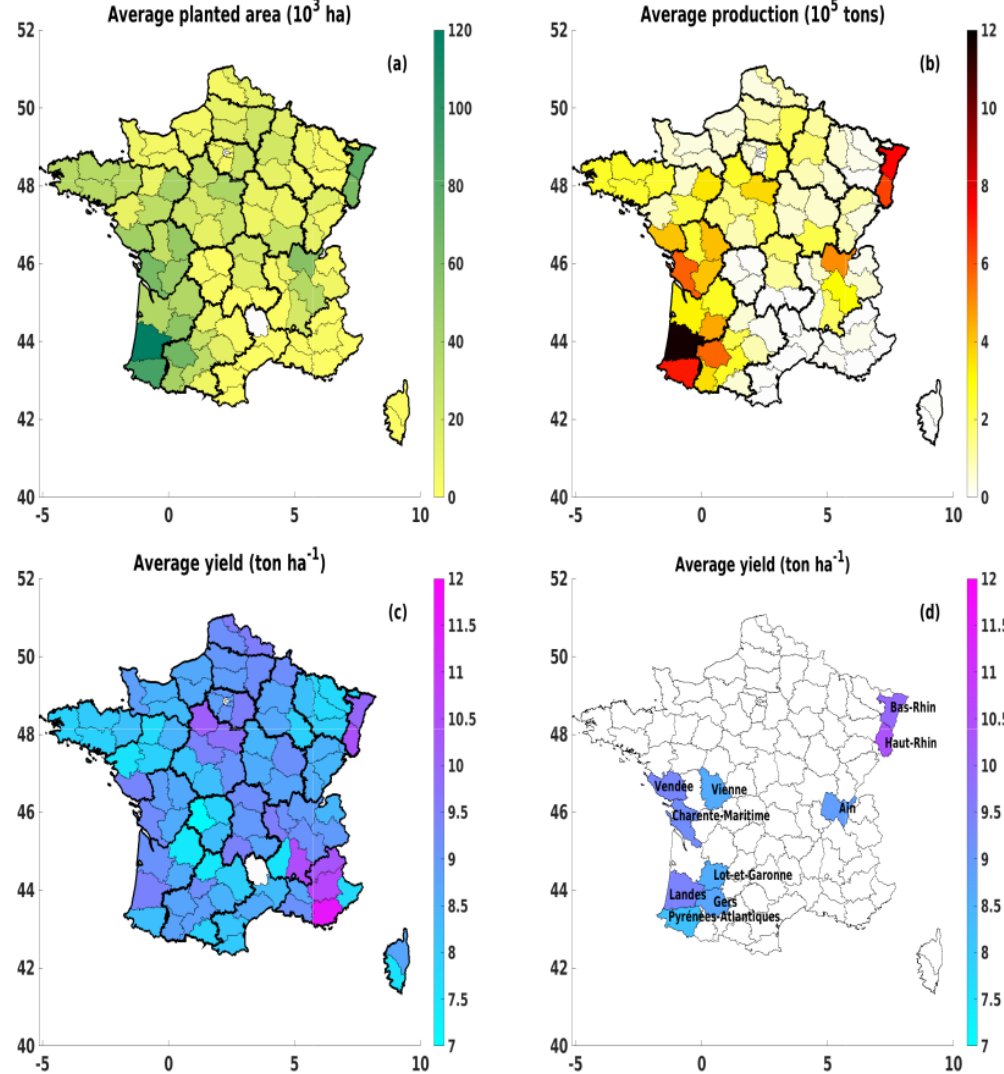
Figure 1. Grain maize database: (a) the average planted area (in 10 3 ha), (b) the average production (in 10 5 t), and (c) the average yield (in tha − 1 ) over 96 French departments (dark lines are regions); (d) same as (c) but presenting only 10 major grain-maize-producing departments. All data are averaged from